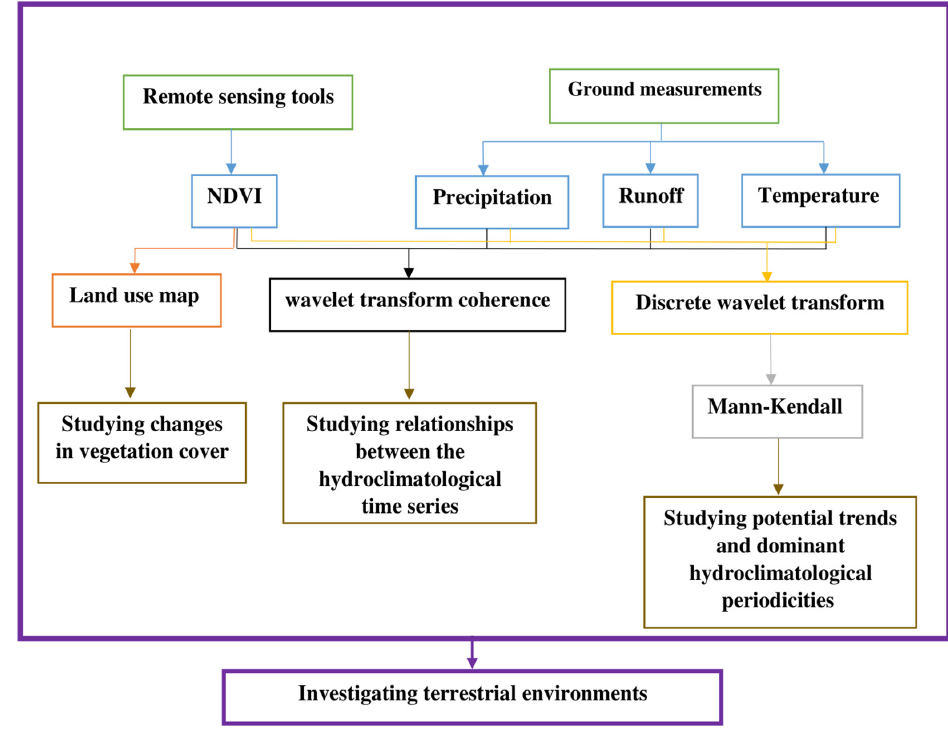
Figure 1. Graphical abstract of the current study.